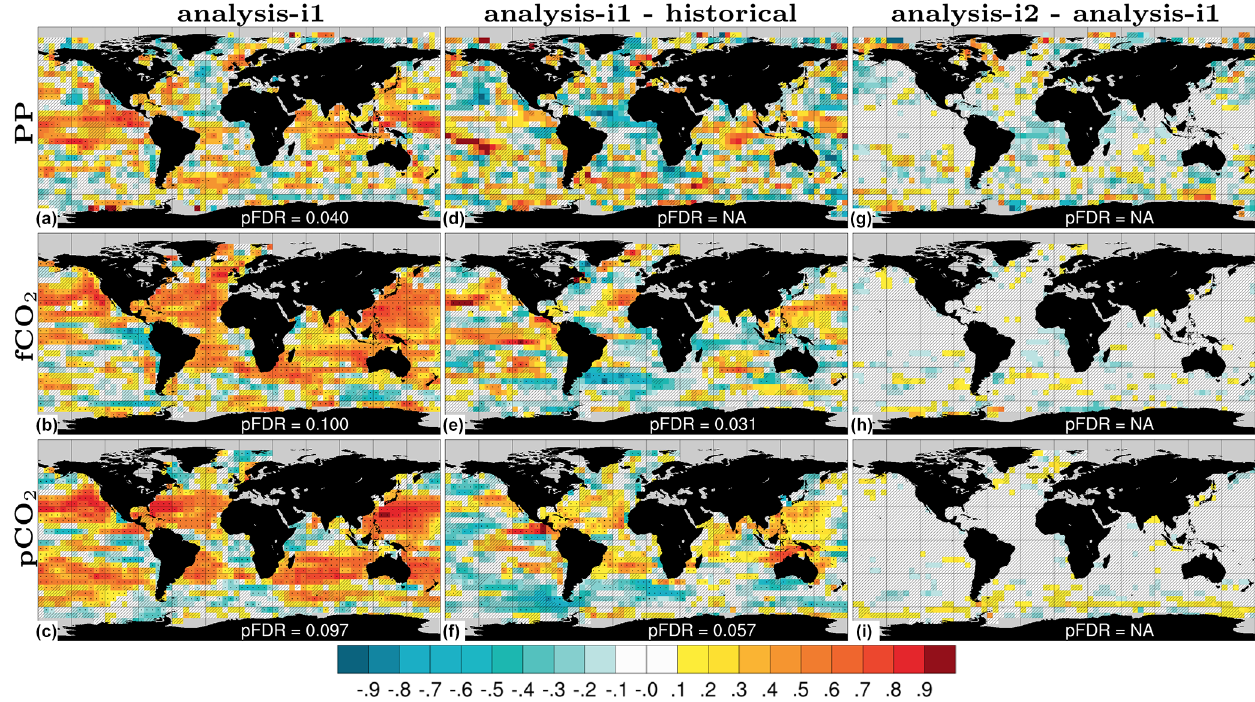
Figure 8. ACC for annual primary production (a) , CO 2 flux (b) and surface p CO 2 (c) for assim-i1 . (cid:49) ACC for assim-i1 – historical (d–f) , assim-i2 – assim-i1 (g–i) . Temporal coverage is 1998–2018 for observed primary production (GlobColour; Garnesson et al., 2019) and 1982– 2017 for CO 2 flux and surface p CO 2 (SOCCOM; Landschützer et al., 2019). The linear trend has been removed from the data. Hatched areas are not locally significant; dotted areas are field